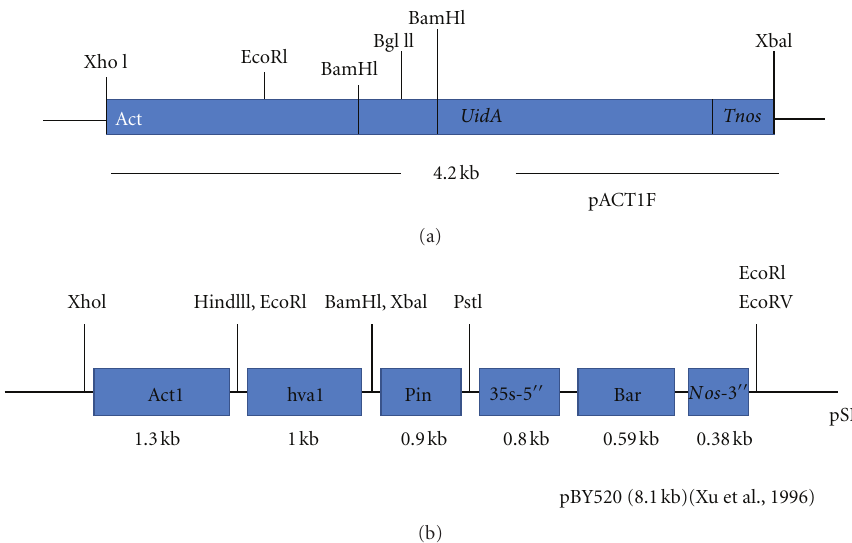
Figure 1: Plasmid constructs. (a) Linear map of pACT1F plasmid vector. Rice actin promoter (Act1), gus gene ( uidA ), and nopaline synthase terminator ( Tnos ); (b) linear map of pBY520 plasmid vector. Rice actin promoter (Act1) and potato protease inhibitor II (Pin II-3 (cid:2) ) terminator, Barley or Hordeum vulgare ( HVA1 ) LEA 3 gene, Cauliflower Mosaic Virus 35S promoter, bar gene and nopaline synthase terminator ( Nos- 3 (cid:2)